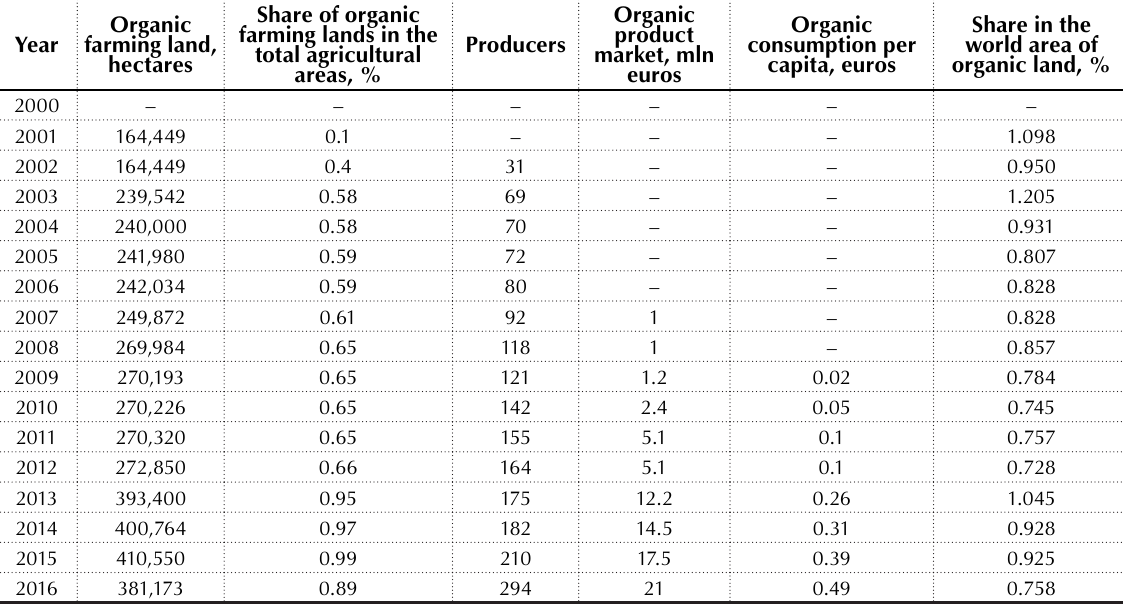
Table 1. Key indicators of the organic farming development in